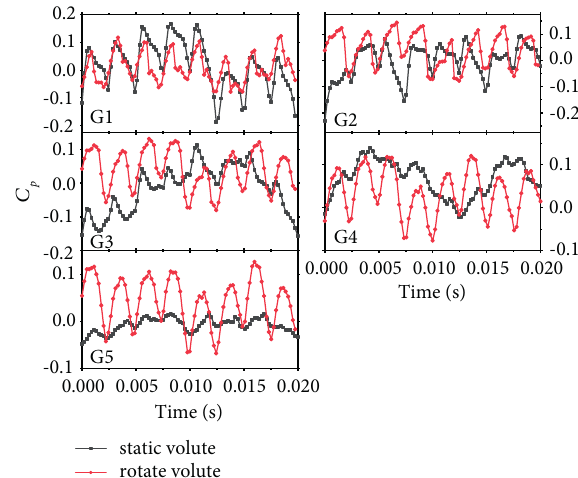
Figure 14: Comparison of pump performance among rotate and static volute.